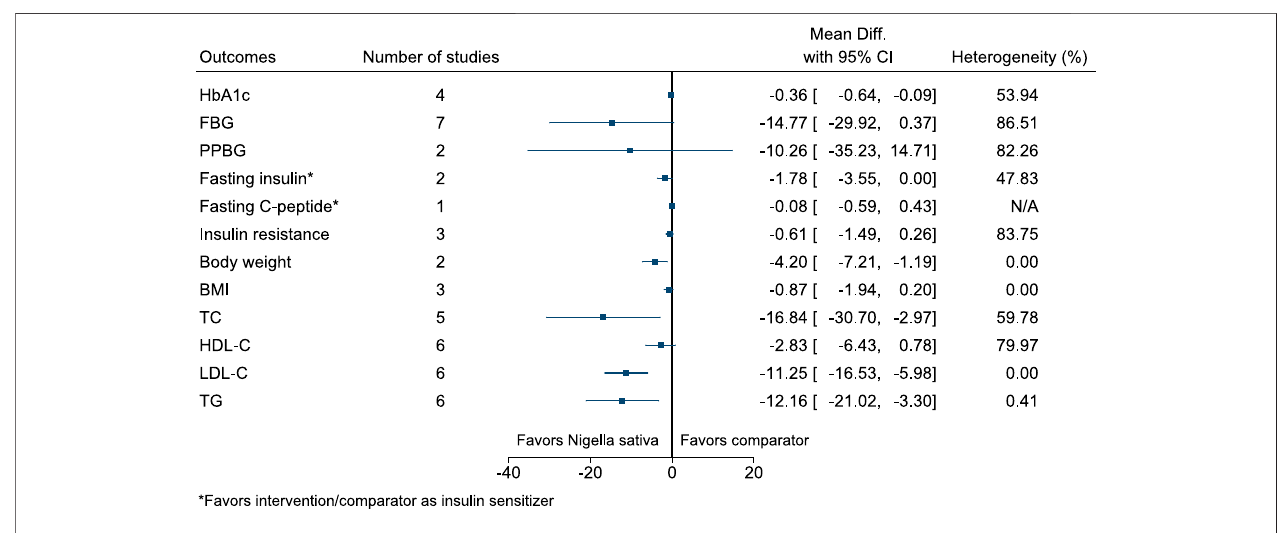
FIGURE 24 | Nigella sativa — Summary forest